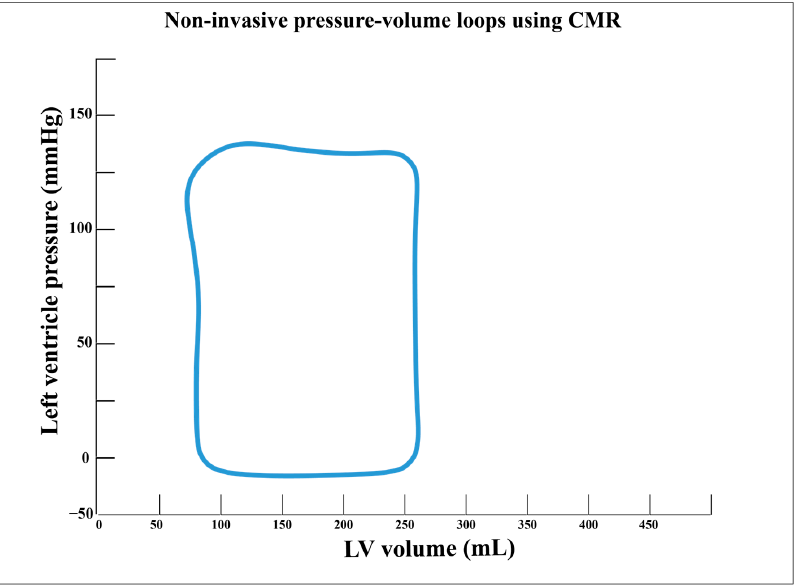
Figure 3. Non ‐ invasive assessment of pressure ‐ volume loops using cardiac magnetic resonance im ‐ Figure 3. Non-invasive assessment of pressure-volume loops using cardiac magnetic resonance aging.